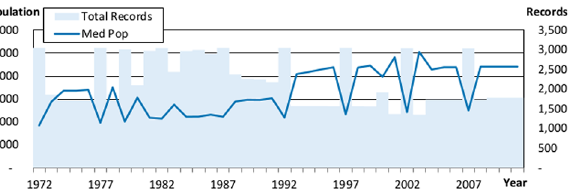
Fig 3. The Relationship between Sample Size and Population for Counties. This figure shows how the median population reported in the data for counties correlates with the number of total records found in the data for counties. Median population is graphed against the left hand axis and the number of records is graphed against the right hand